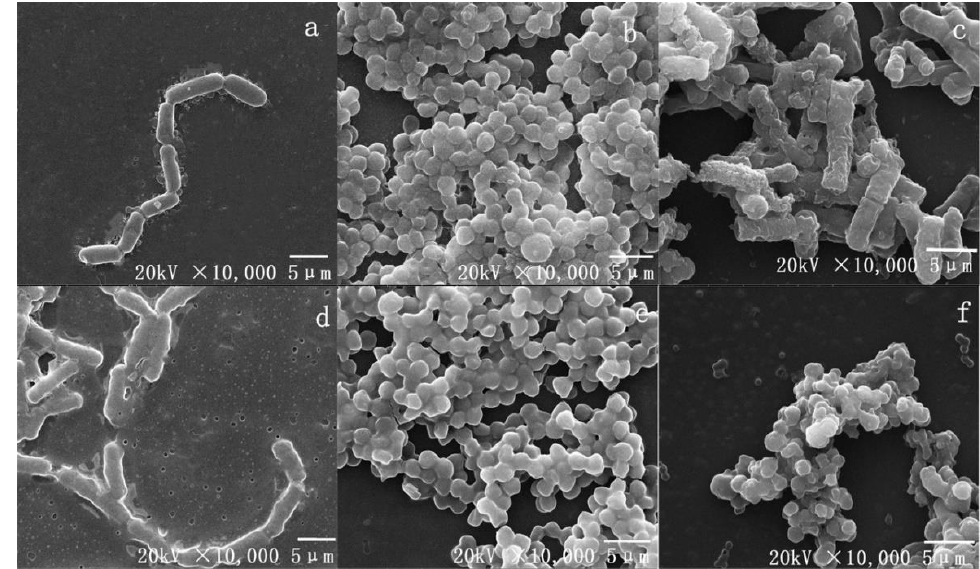
Figure 4. The SEM photography, control: ( a ): E. coli , ( b ): S. aureus , ( c ): H. pylori . Treated with EPS